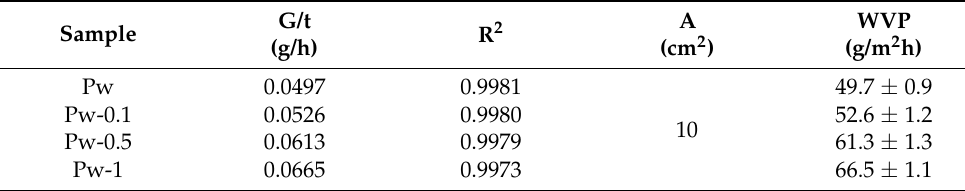
Table 1. WVP coefficients of PU-based magnetic composite